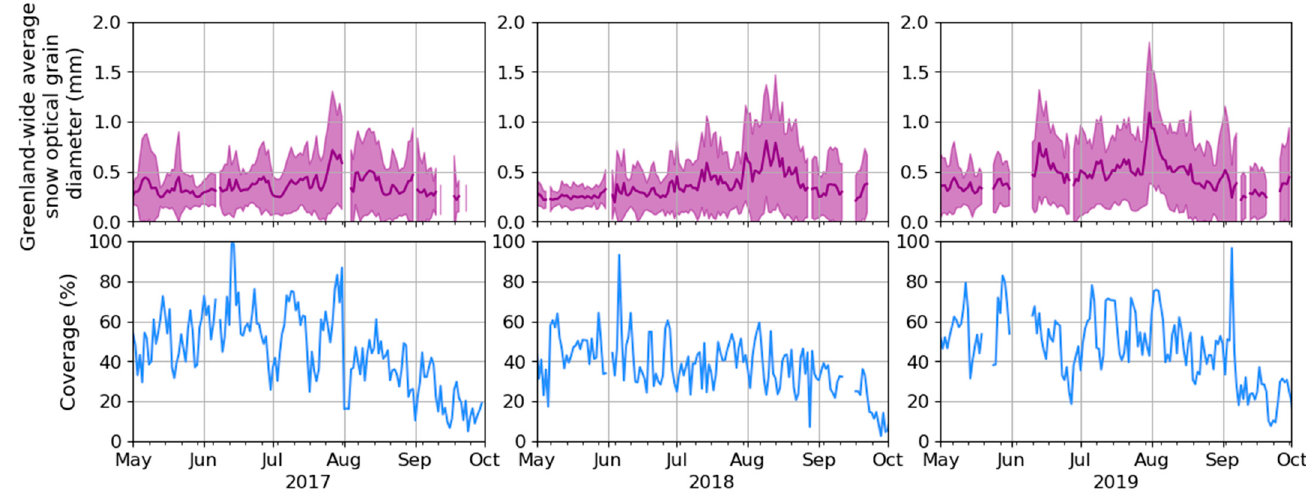
Figure 2. Greenland-wide average snow optical grain diameter ( d opt ), ± 1 standard deviation, and retrieval coverage as percent of Greenland ice sheet pixels for which retrieval was possible.